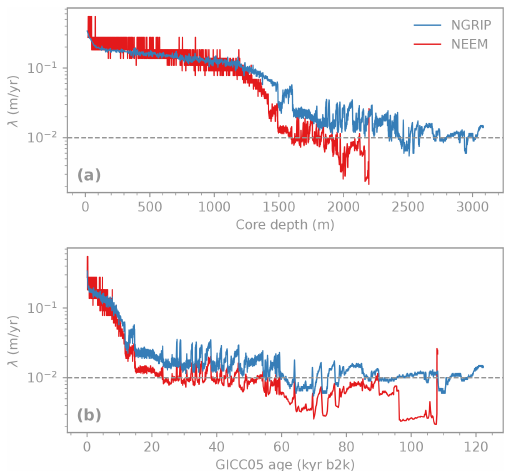
Figure 6. Annual layer thickness of the NGRIP and NEEM GICC05modelext age scales as a function of depth (a) and age (b) . The horizontal dashed line indicates 1cm, the effective resolution of the data presented